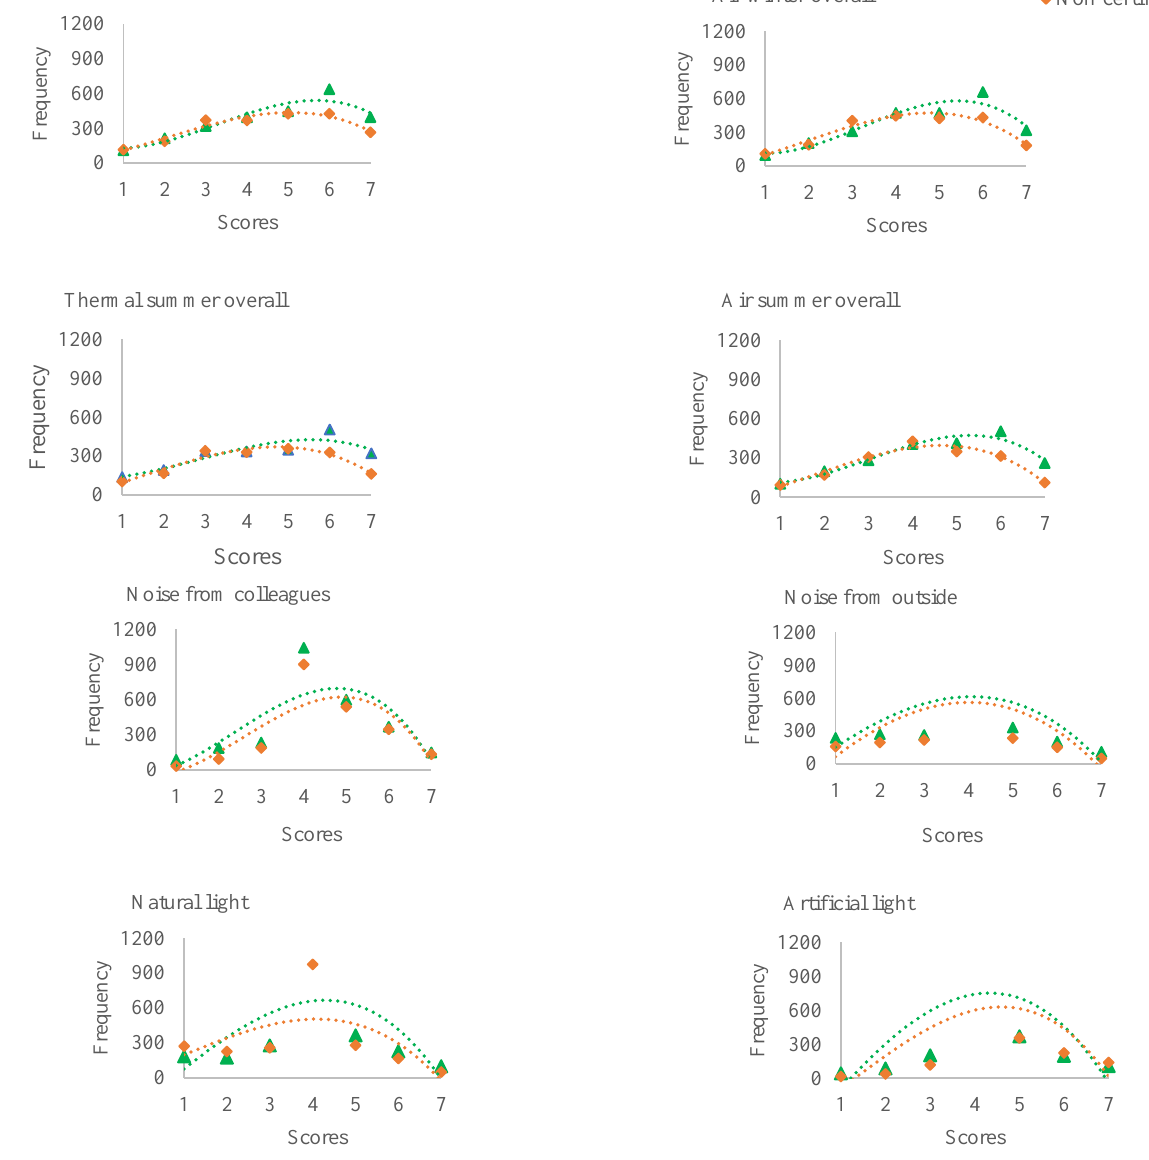
Table 5. Mean differences and effect size calculation comparing green and non-certified buildings regarding operational parameters.